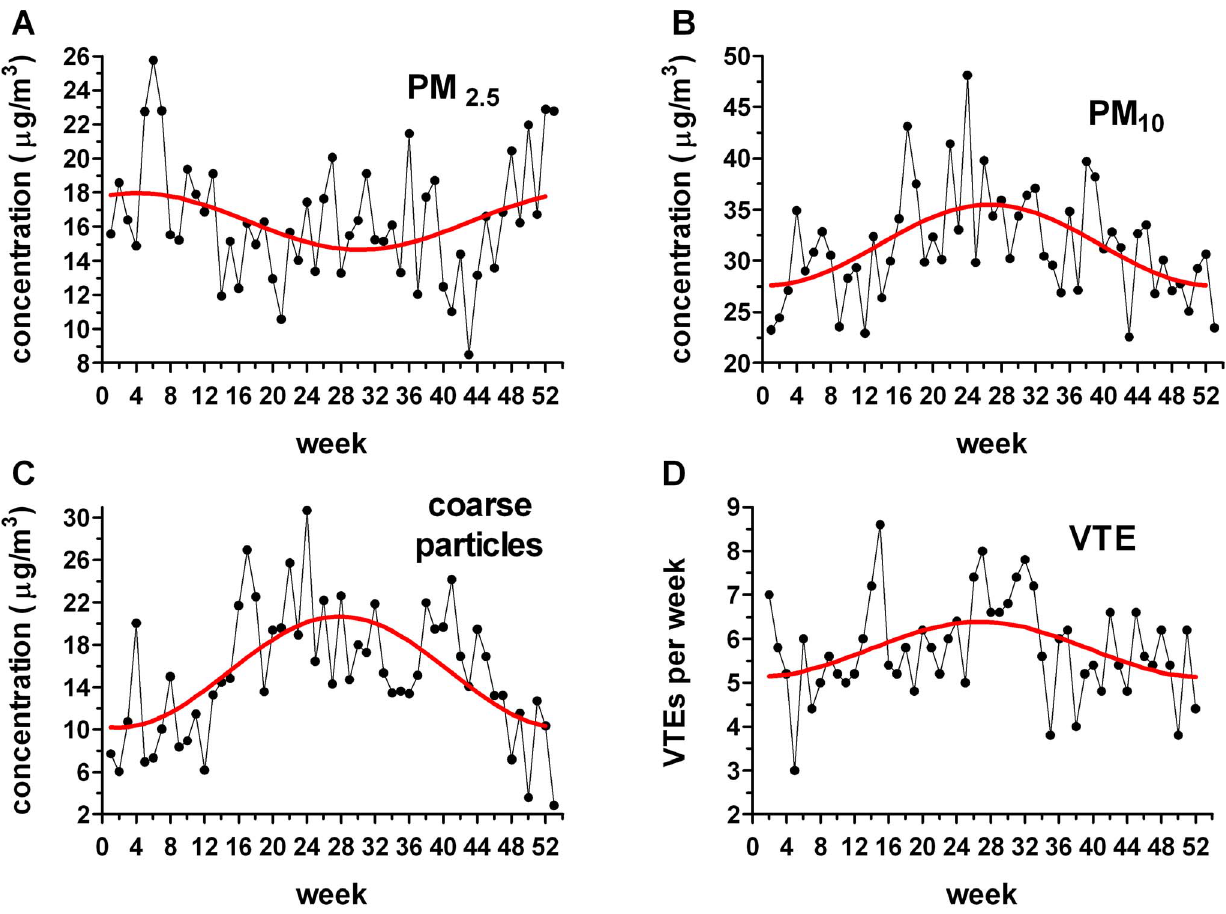
Figure 6. Weekly distribution of particulate matter (PM) parameters and venous thromboembolism (VTE) cases (Detroit hospitals). Periodic regressions are shown in red. (A) 2.5 m m PM ( P =0.049; R 2 =0.12); January 26 th peak. (B) 10 m m PM ( P =0.0003; R 2 =0.28); July 2 nd peak. (C) Coarse particles ( P , 0.0001; R 2 =0.40); July 11 th peak. (D) VTE cases per week per year ( P =0.018; R 2 =0.15); July 3 rd peak.